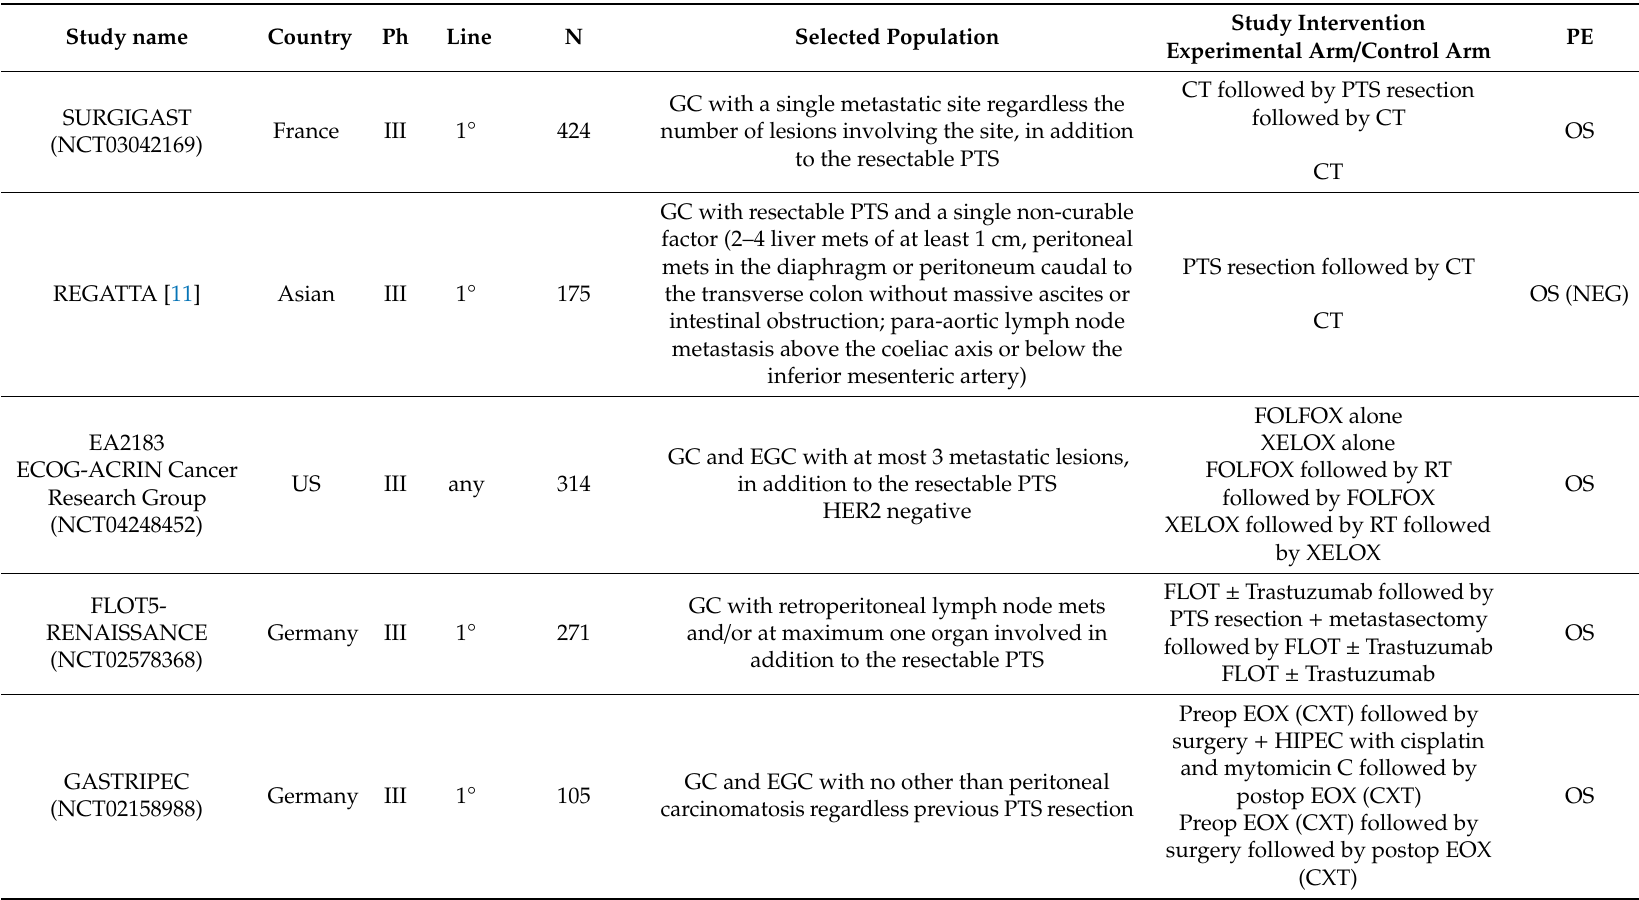
Table 3. List of ongoing or completed phase III or II-III trials evaluating surgery and locoregional treatments in metastatic gastric